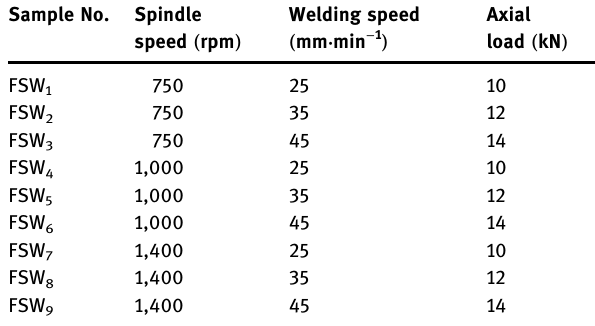
Table 1: Corrosion specimen details Sample No.